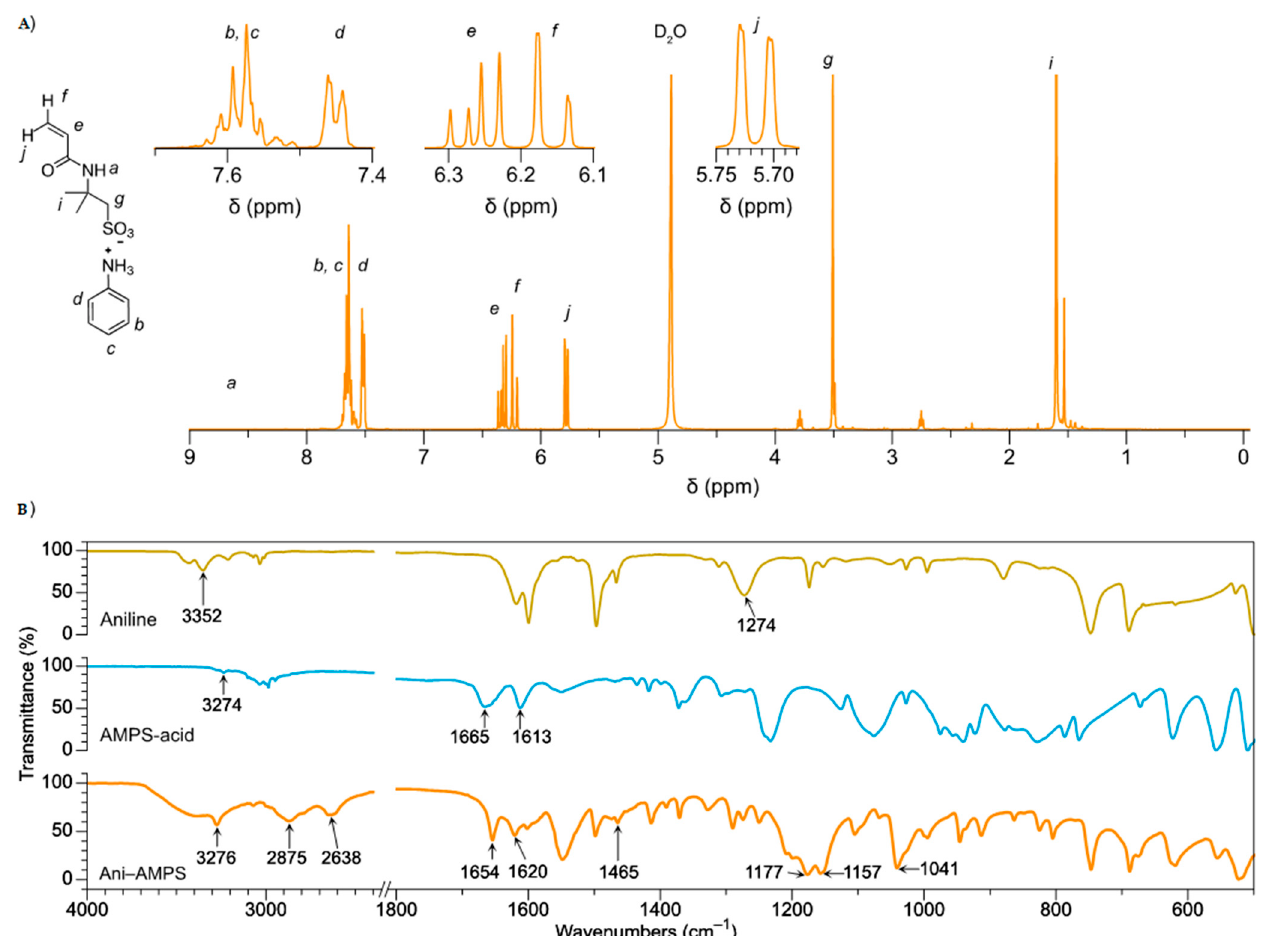
Figure 2. Ani-AMPS monomer spectra: ( A ) 1 H NMR (solvent: deuterium oxide) δ 7.64–7.54 (m, 3H), 7.45 (dt, J = 8.0, 1.5 Hz, 2H), 6.26 (dd, J = 17.1, 10.1 Hz, 1H), 6.16 (dd, J = 17.1, 1.5 Hz, 1H), 5.72 (dd, J = 10.1, 1.5 Hz, 1H), 3.44 (s, 2H), 1.53 (s, 6H) and ( B ) FTIR spectra, comparison of Ani-AMPS versus aniline and AMPS-acid.